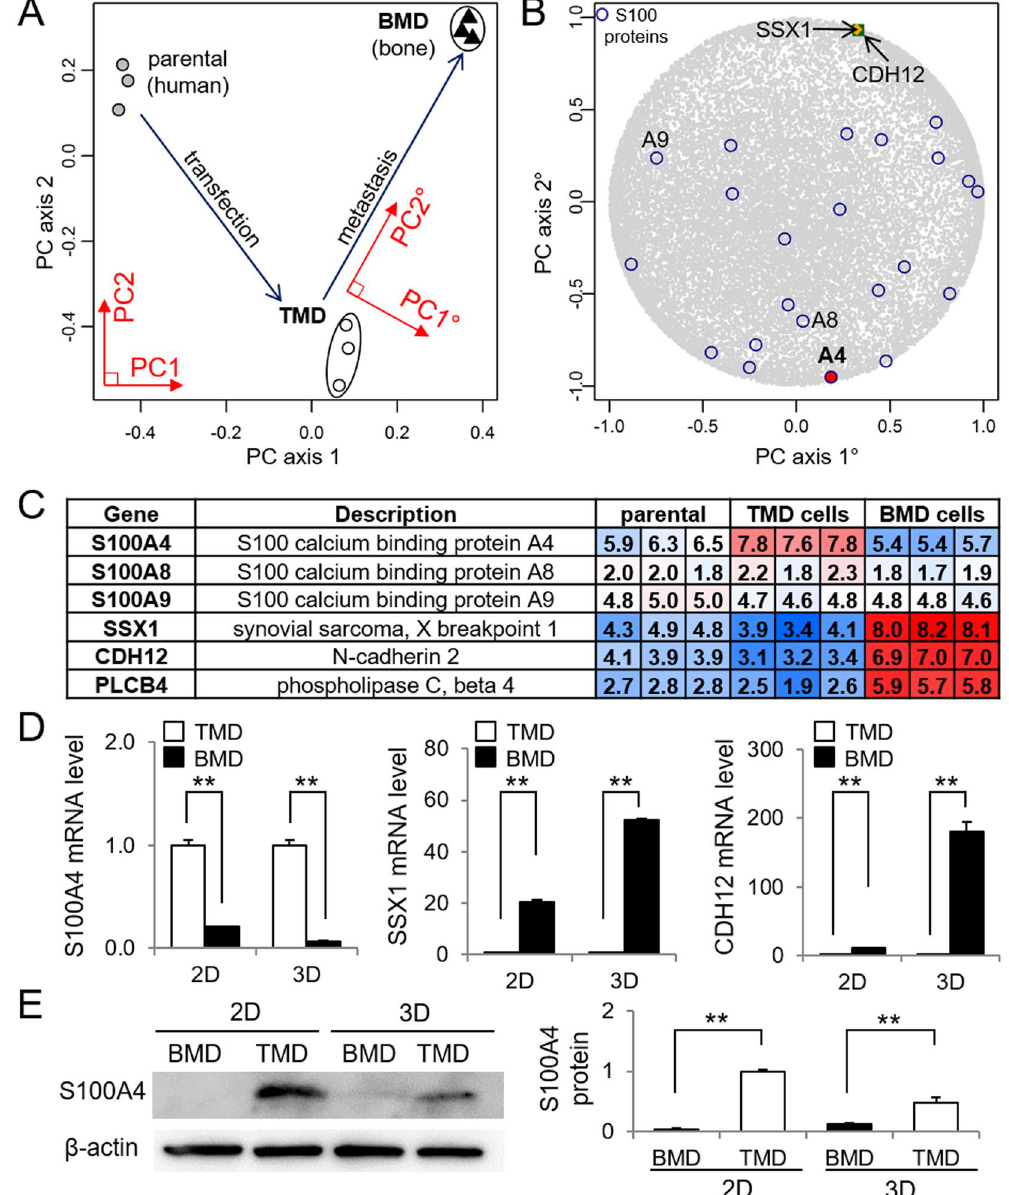
Figure 2. Genome-wide mRNA expression analysis of TMD cells and BMD cells. Of note, PC = principal component, 2D = 2-dimensional culture, and 3D = 3-dimensional spheroid culture. The double asterisks indicate p < 0.01. ( A ) Projection of three cell lines in the first/second PC array plane (PC1 and PC2). ( B ) Projection of S100 proteins and others in the PC gene plane (PC1° and PC2°). Note that the metastasis axis (PC2° axis) is ~20° tilted from the second PC axis (PC2 axis). ( C ) Representative genes whose mRNA expression levels are significantly different in TMD cells and BMD cells along the metastasis axis. ( D ) qPCR confirmation of mRNA expression levels of S100A4, SSX1, and CDH12 in TMD cells and BMD cells in 2-dimensional and 3-dimensional (spheroid) cultures. ( E ) Elevated protein level of S100A4 in TMD cells in 2- and 3-dimensional cultures. Full length blots are presented in Supplementary Figure